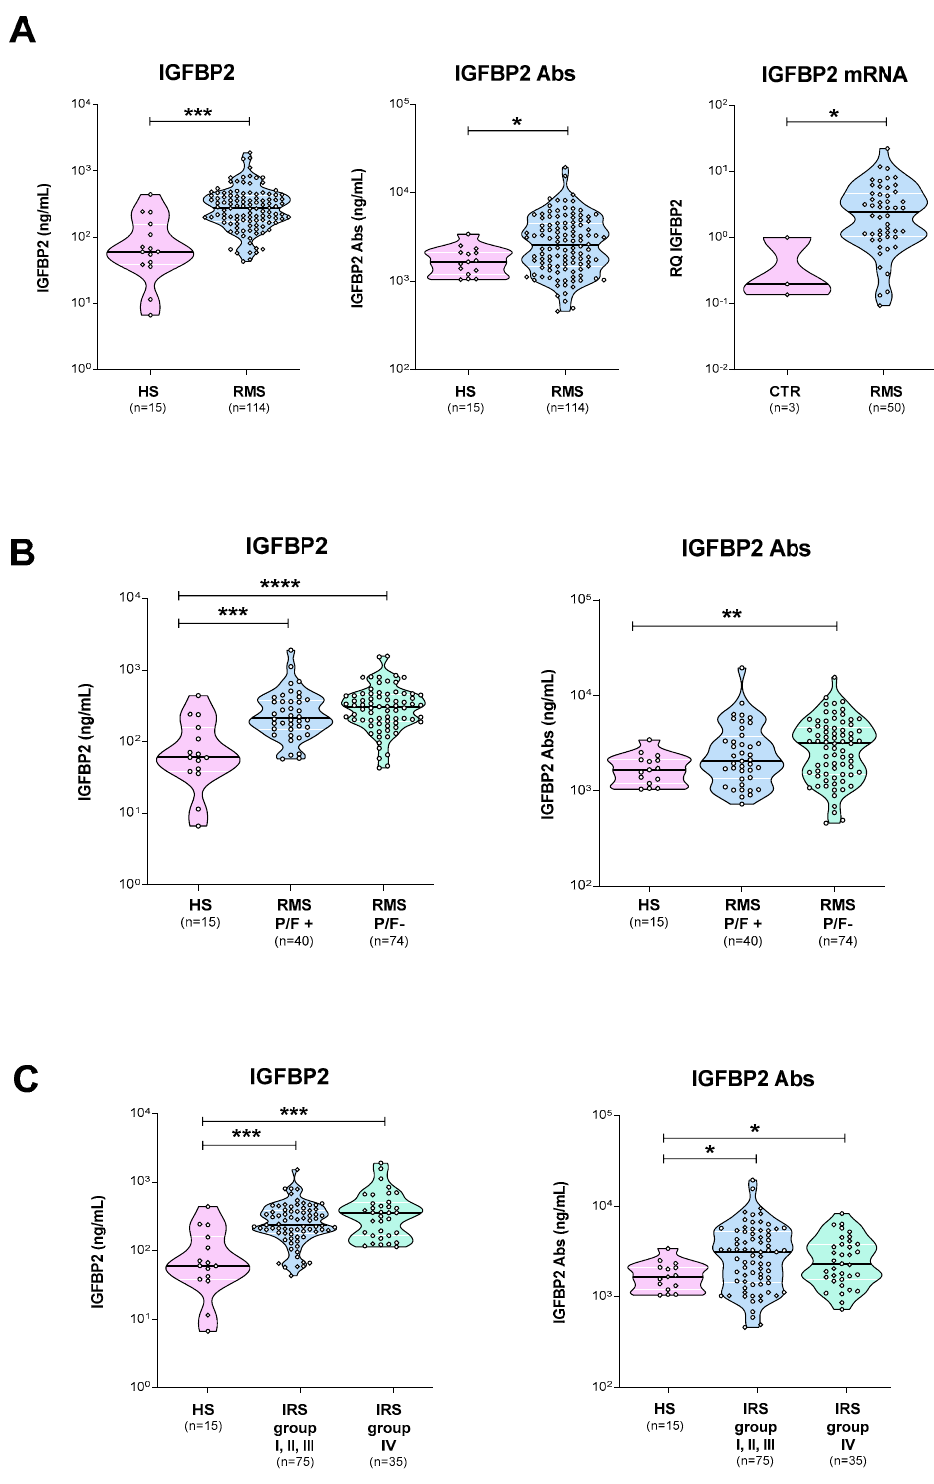
Figure 1. Plasmatic IGFBP2 protein and autoantibodies levels in RMS patients. ( A ) IGFBP2 protein and autoantibodies (Abs) in healthy subjects (HS) and RMS patients (RMS) (left and central panels). IGFBP2 mRNA levels in RMS patients and controls (right panel). Plasmatic levels of IGFBP2 protein and autoantibodies in RMS patients distinguished according to ( B ) fusion status or ( C ) IRS group classification. P / F + , PAX3 / 7-FOXO1 -positive; P / F- , PAX3 / 7-FOXO1- negative; FOXO1 , forkhead box protein 1; PAX3 , paired box 3; PAX7 , paired box 7; p < 0.05 (*); p < 0.01 (**); p < 0.001 (***); p < 0.0001 (****).